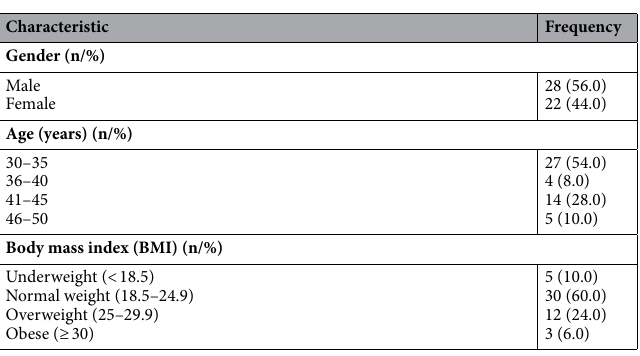
Table 2. Changes in vital sign of participant during study. mmHg millimetre of mercury; BPM beats per minute; o C Celsius. Values were expressed as means ± SD. Statistically significant p values are marked in asterisks (*). a p-value was calculated using general linear model (GLM) for repeated measures model, with sampling time point as within-subjects factor.